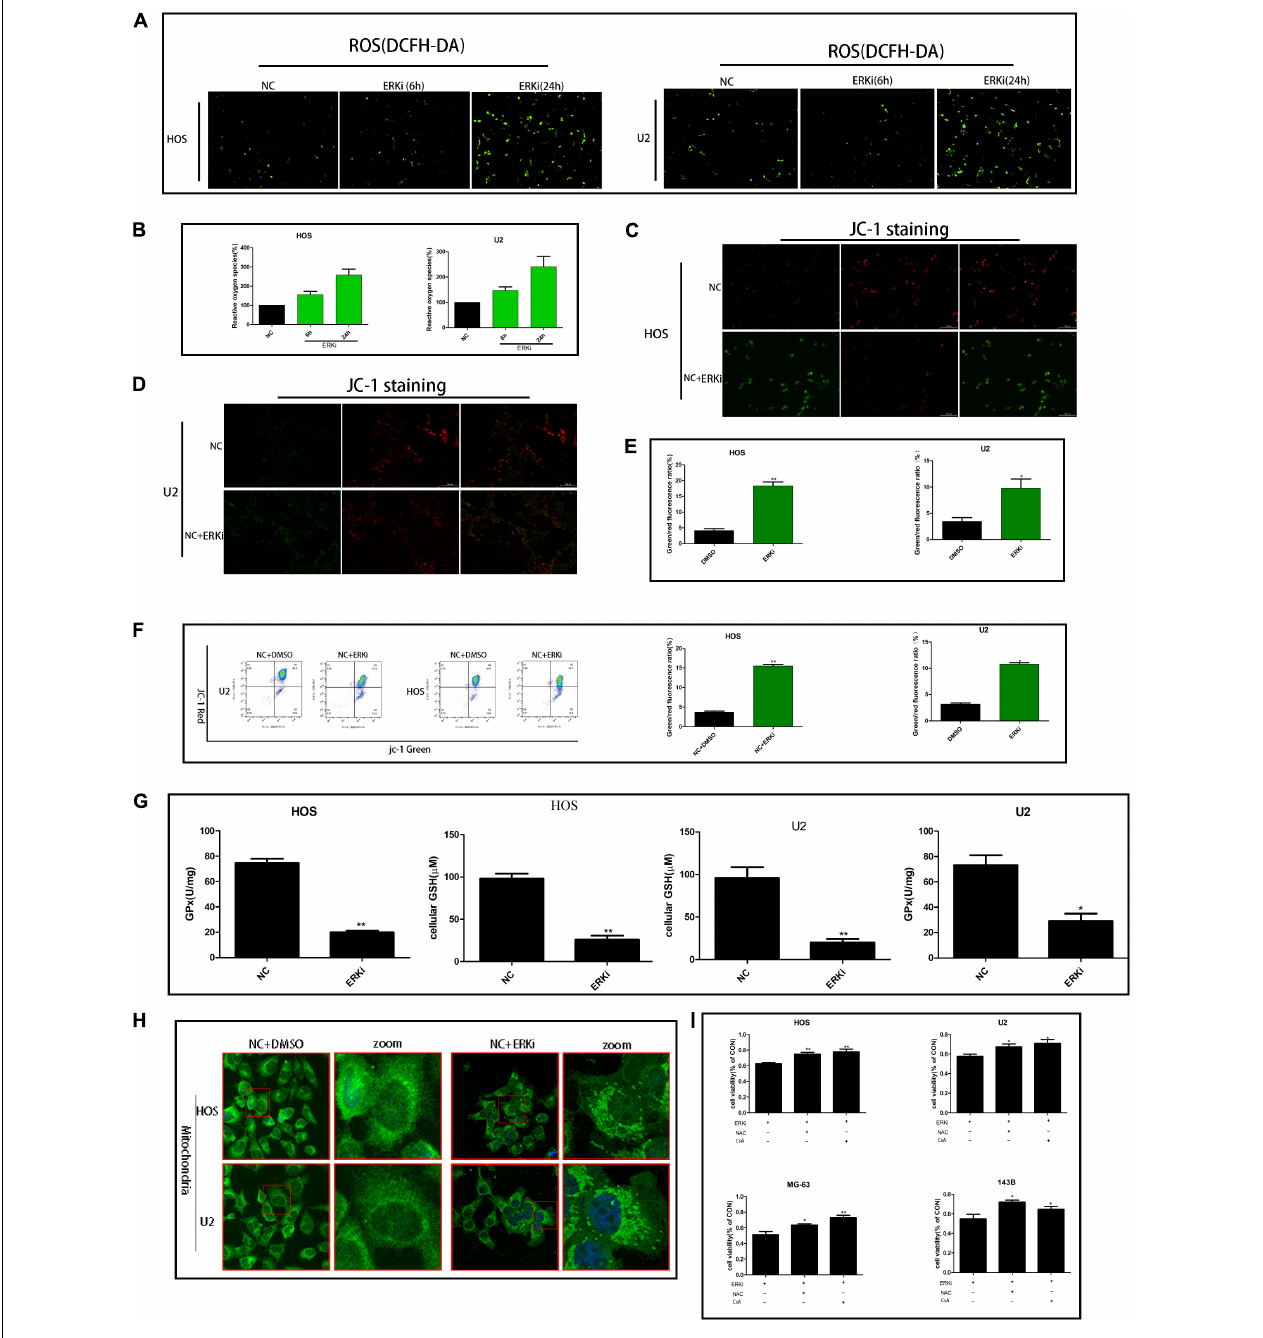
FIGURE 3 | ERK inhibition regulates the mitochondrial activity of OS cells. (A,B) ROS fluorescence probe analysis. (C–E) JC-1 staining for comparing mitochondrial depolarization of OS cell lines among groups . (F) Flow cytometry was used to measure JC-1 of OS cells. (G) Effect of ERKi on GPx and GSH levels in OS cells. (H) Immunofluorescence co-staining of mitochondria in OS cells 24 h post-ERKi treatment (I) Cell-survival rate in different groups ( n = 5 per group; ** p < 0.01 versus NC group; * p < 0.05 versus NC